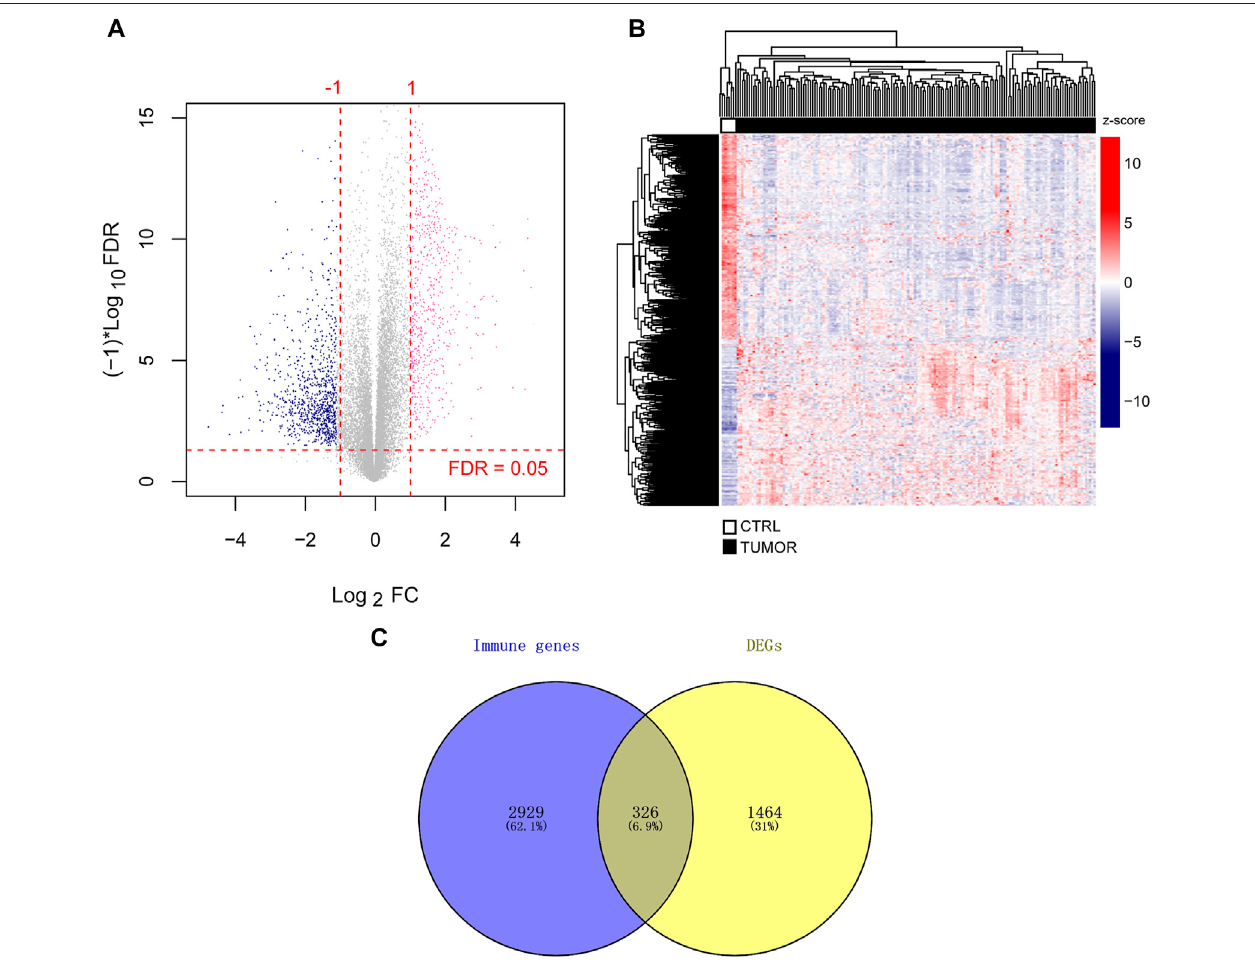
FIGURE 1 | Identi fi cation of immune-related DEGs. (A) DEGs volcano map. The horizontal axis depicted the effect size (log 2 FC), while the vertical axis depicted -log10(FDR).ThepinkandbluedotsrepresentedDEGsthathavebeenupregulatedordownregulated,respectively.FDR < 0.05isindicatedabovethehorizontaldashed line, and |log 2 FC| > 1 is indicated outside the two vertical dashed lines. (B) Heatmap of DEGs. (C) Immune-related genes and DEGs Venn diagram. FDR stands for false discovery rate and DEGs stand for differentially expressed genes. Fold change,